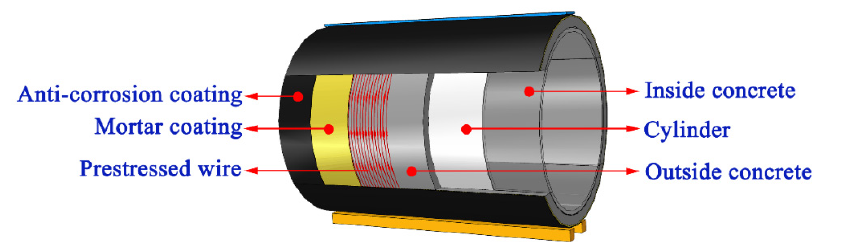
Figure 1. Schematic diagram of the composition of embedded PCCP.